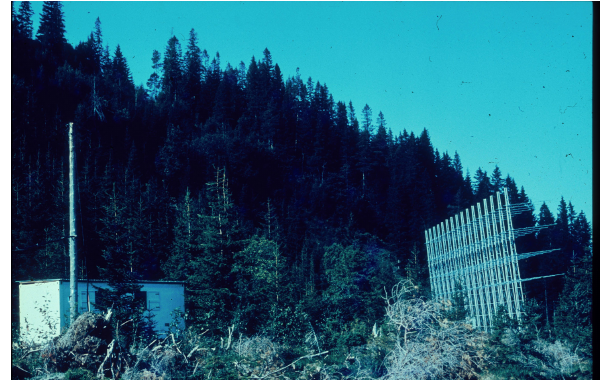
Figure 2. Receiving array (about 30m length) and container with